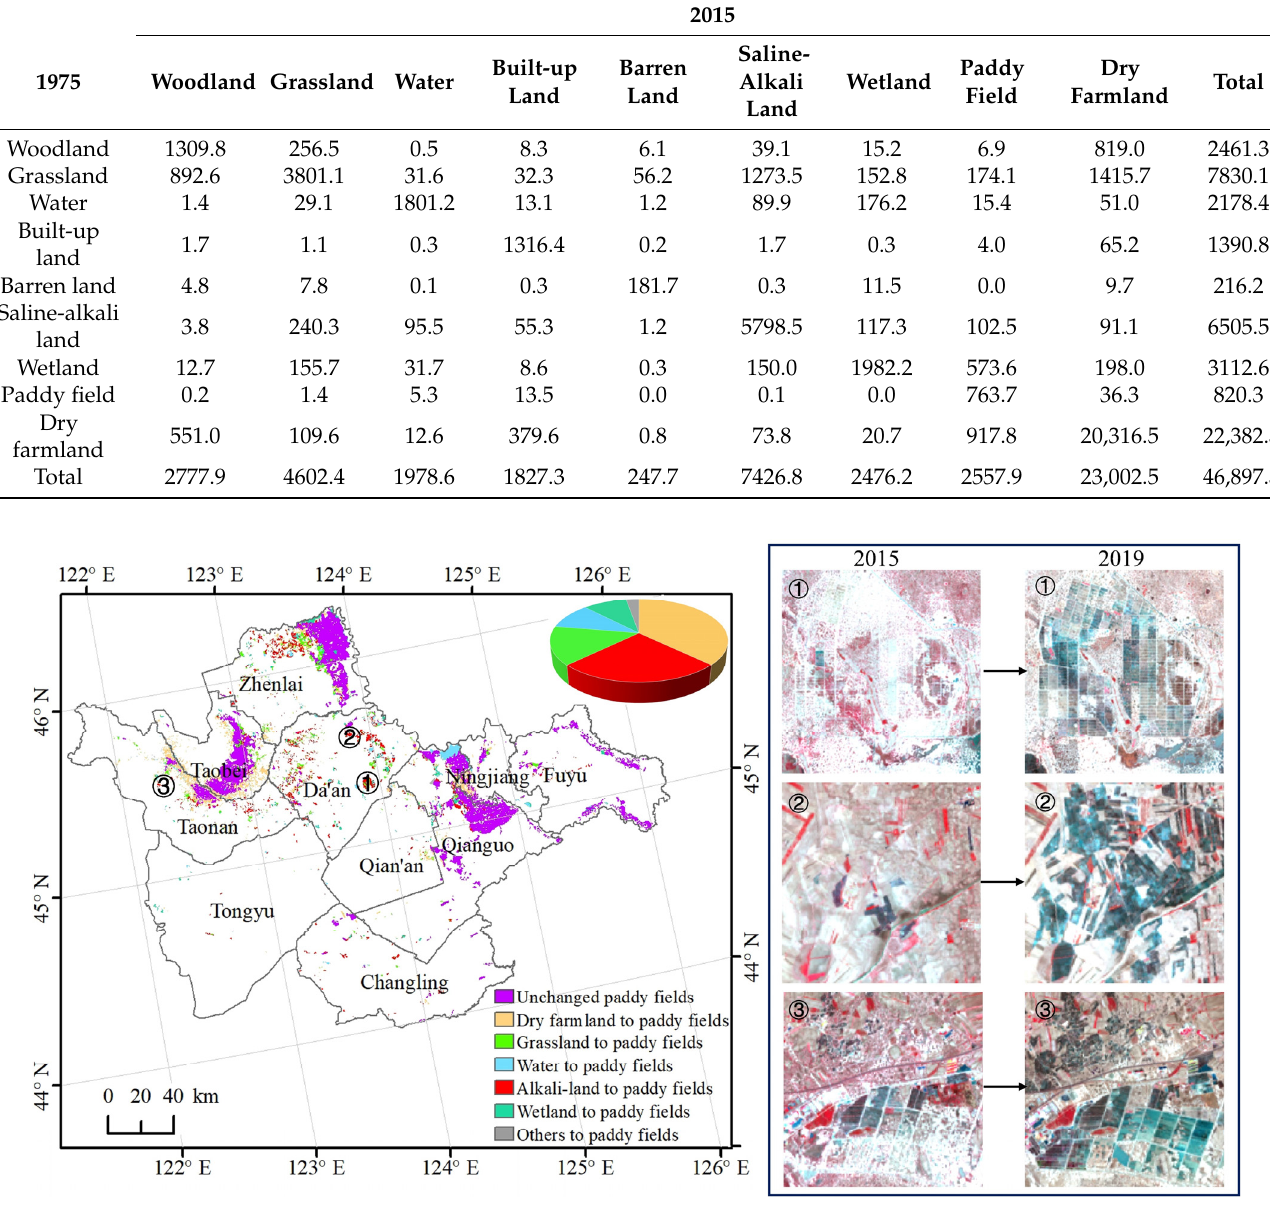
Figure 4. The paddy fields increase in western Jilin from 2015 to 2019.